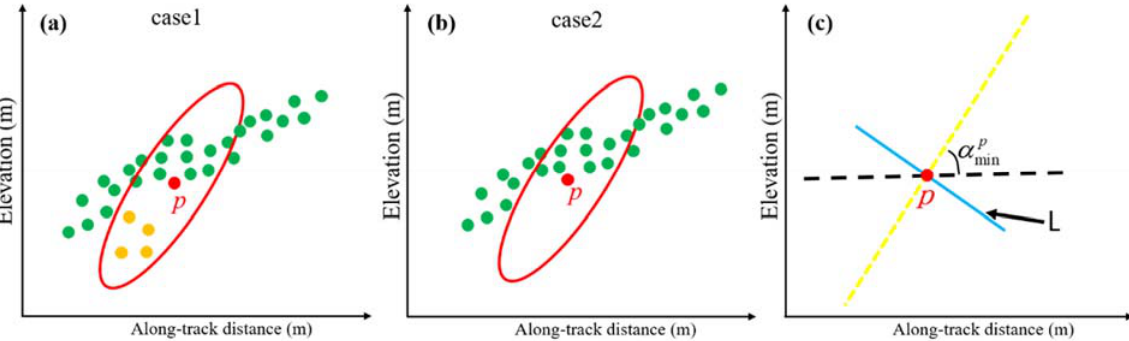
Figure 5. ( a ) and ( b ) geometrical explanations of (5). Schematic diagrams of ( c ) the ellipse divided into two parts by line L . Green dots represent signal photons; Yellow dots represent noise photons that are adjacent to signal photons.